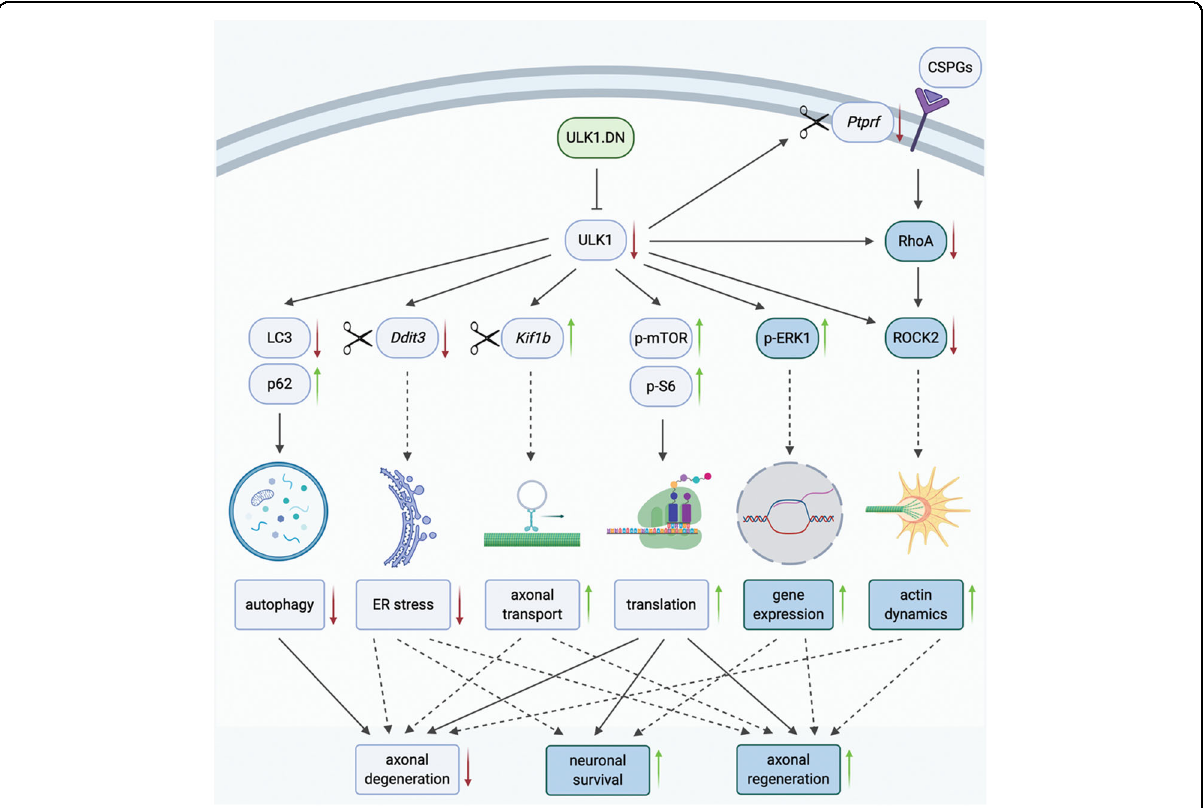
Fig. 8 Overview of the molecular mechanisms underlying the effects of AAV.ULK1.DN-mediated ULK1 inhibition on axonal degeneration, neuronal survival, and axonal regeneration. We have previously demonstrated that inhibition of ULK1 function via expression of dominant- negative ULK1 (ULK1.DN) attenuates axonal degeneration in different models of axonal injury in vitro and in vivo 14 . We connected these fi ndings to reduced autophagy, increased mTOR-dependent translation, and differential splicing of the genes Kif1b and Ddit3 , which we hypothesized to enhance axonal transport and reduce ER stress (previous results depicted in light blue). In this study, we additionally demonstrate that ULK1.DN- mediated ULK1 inhibition promotes neuronal survival and fosters axonal regeneration after axonal injury (results of this study depicted in dark blue). Mechanistically, we extend our previous fi ndings by demonstrating elevated levels of p-ERK1 after transduction with AAV.ULK1.DN, which could promote survival and enhance the intrinsic axonal growth capacity via increased gene expression. Furthermore, we show reduced expression of the RhoA-ROCK2 pathway in ULK1.DN-transduced neurons, which counteracts the growth-inhibitory effect of glia-derived molecules such as CSPGs after lesion and could result in increased pro-regenerative actin dynamics after lesion. Correspondingly, ULK1.DN also mediates differential splicing of the CSPG receptor Ptprf 14 . Together, we propose that AAV.ULK1.DN-mediated ULK1 inhibition attenuates axonal degeneration, increases neuronal survival, and fosters axonal regeneration after axonal injury via a molecular switch to axon-protective, pro-survival, and growth-promoting pathways. Figure created with